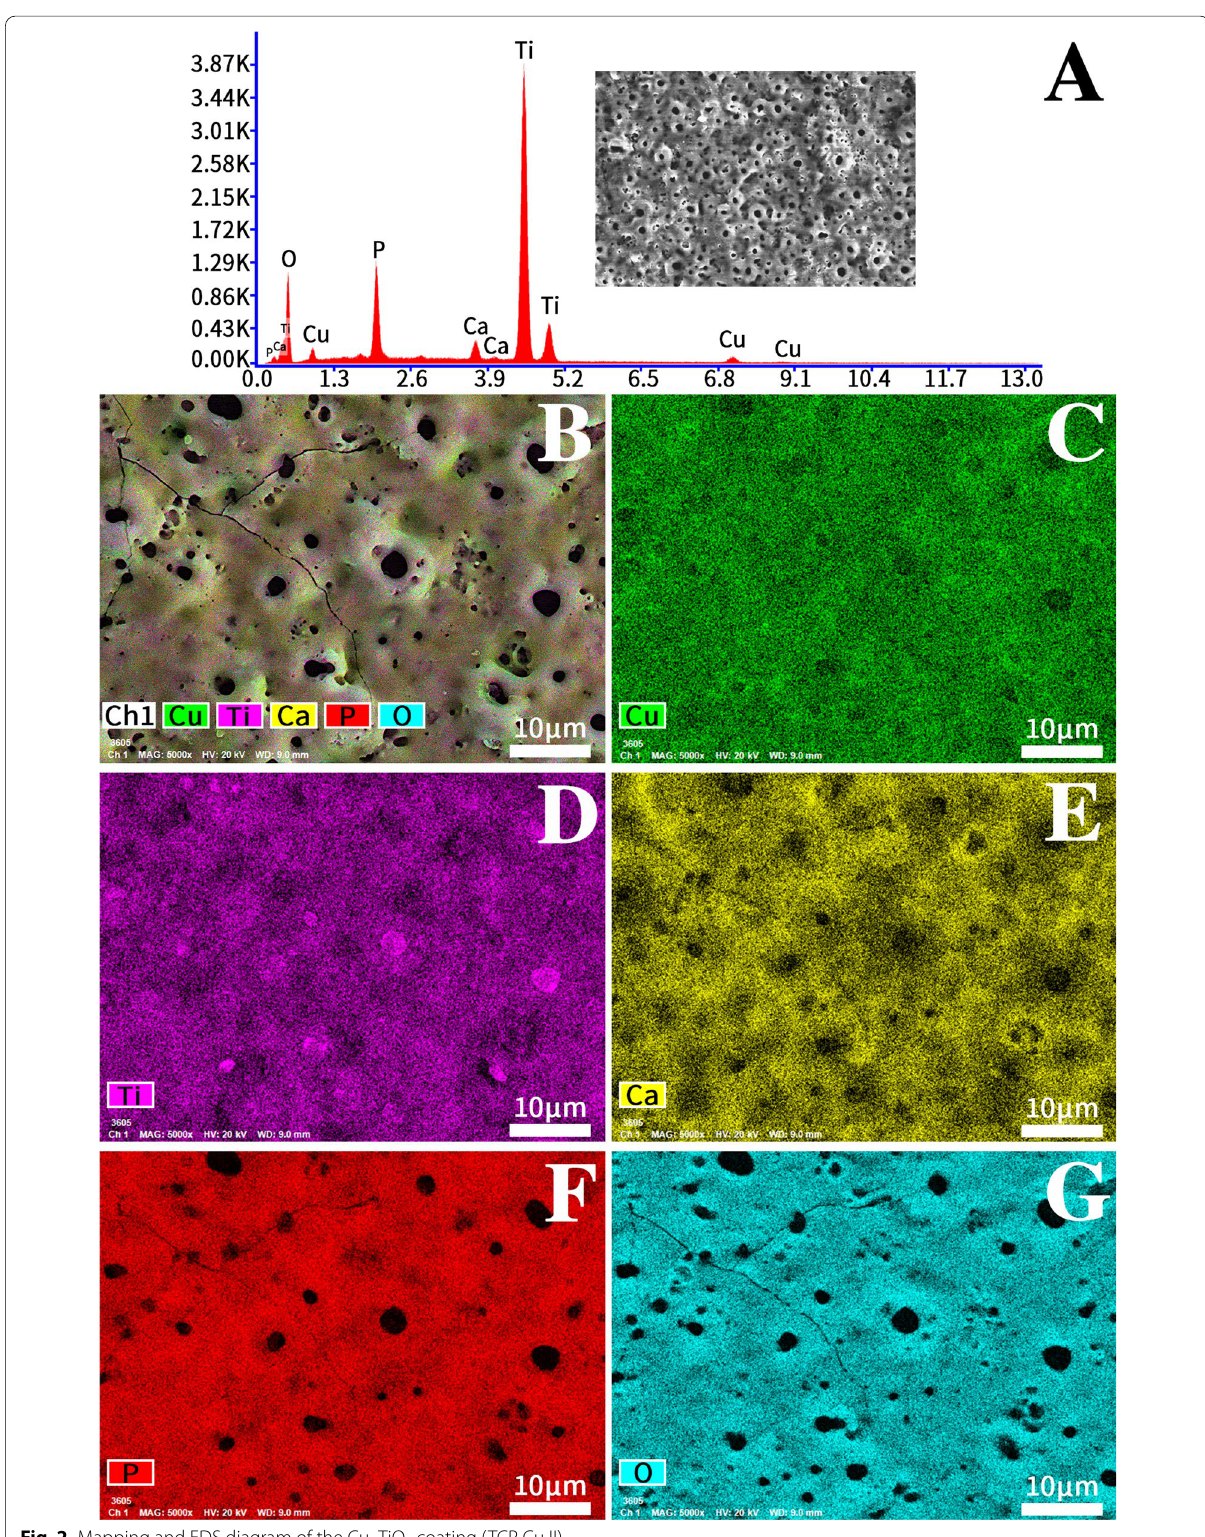
Fig. 2 Mapping and EDS diagram of the Cu–TiO 2 coating (TCP Cu